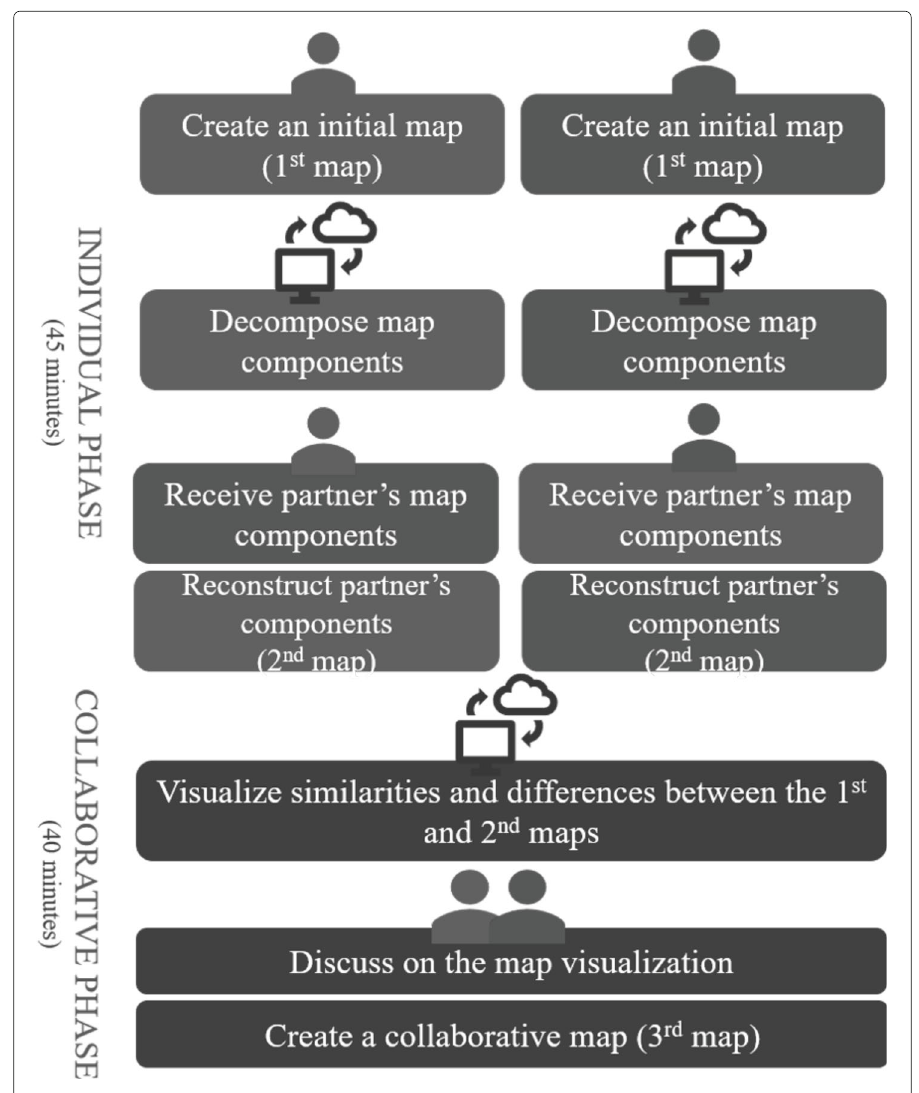
Fig. 1 Sequence of learning